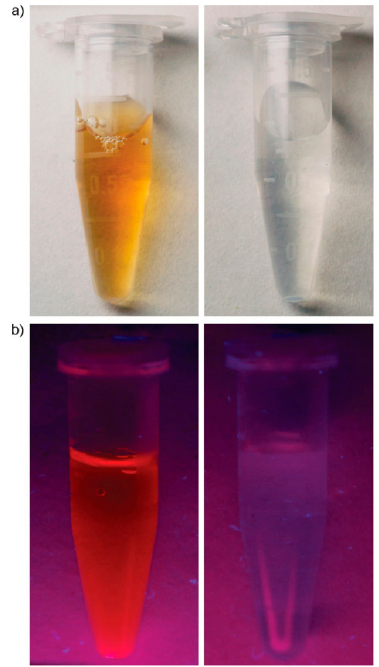
Figure 4. ( a ) Aqueous solution of Au NCs before (left) and after (right) addition of 5 × 10 − 3 M cyanide. ( b ) Fluorescence of the aqueous solution of Au NCs before and after addition of 5 × 10 − 3 M cyanide under UV light at 365 nm (Copyright Ref [58], WILEY publications).